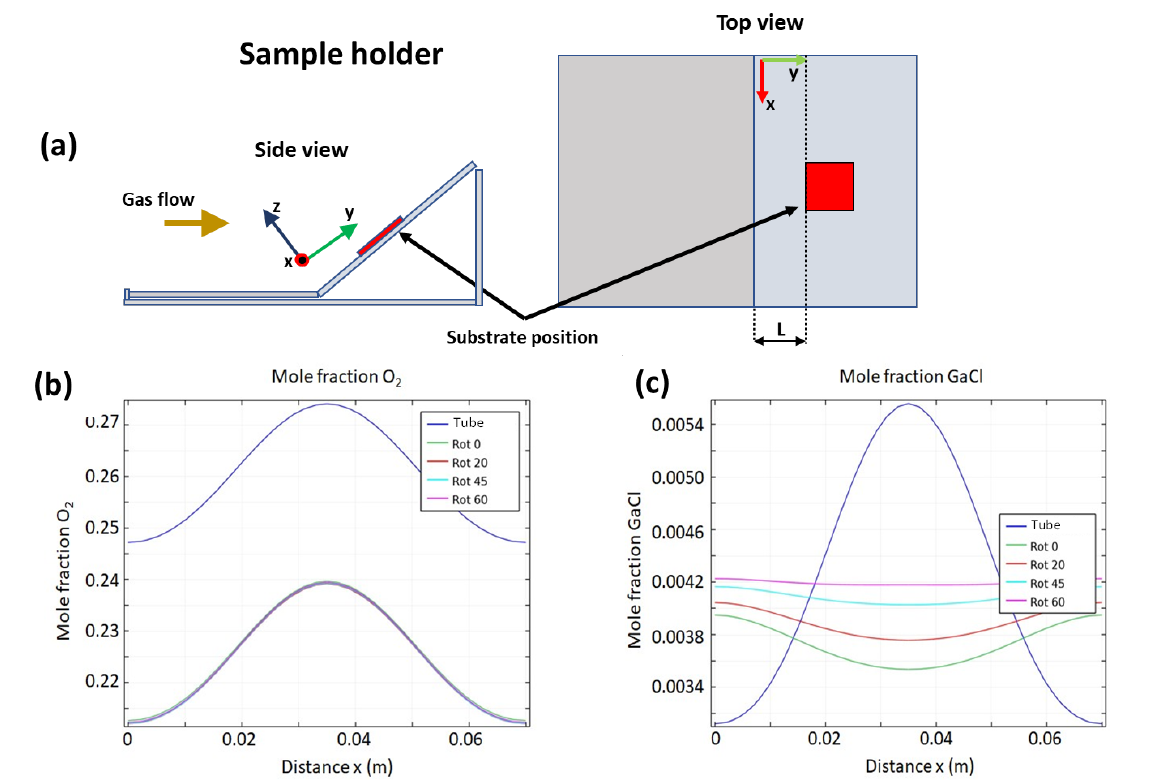
Figure 2. ( a ) Sample holder with a coordinate system and the 2D distribution of ( b ) mole fraction of oxygen and ( c ) mole fraction of GaCl over the sample holder in the x-direction when L = 1 cm from the front edge of the sample holder. The calculations were carried out for different rotation angles of the outlets and compared with the model with a tube as the inlet for GaCl.